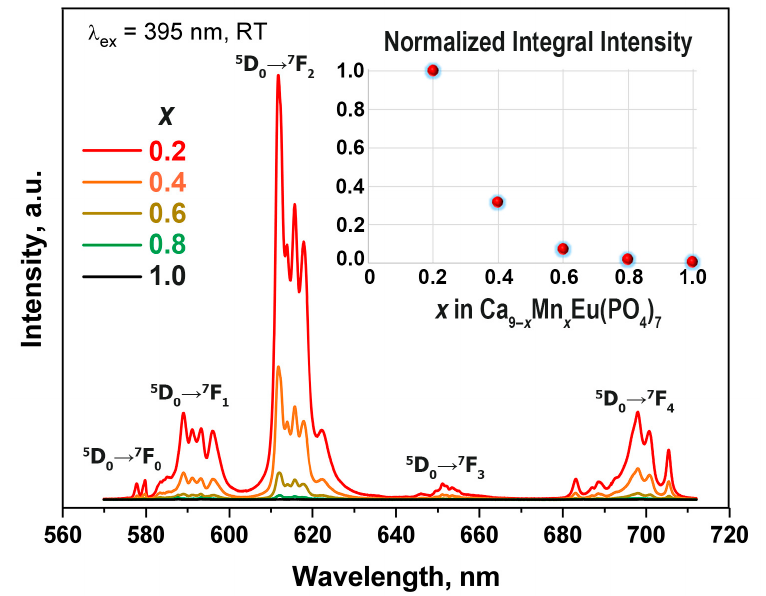
Figure 13. PL spectra for Ca 9 − x Mn x Eu(PO 4 ) 7 at λ ex = 395 nm; the inset shows the dependence of normalized integral intensity on the Mn 2+ concentration in Ca 9 − x Mn x Eu(PO 4 ) 7 . PL spectra for Ca 9 − x Mn x Eu(PO 4 ) 7 solid solutions at 370 nm excitation are shown in